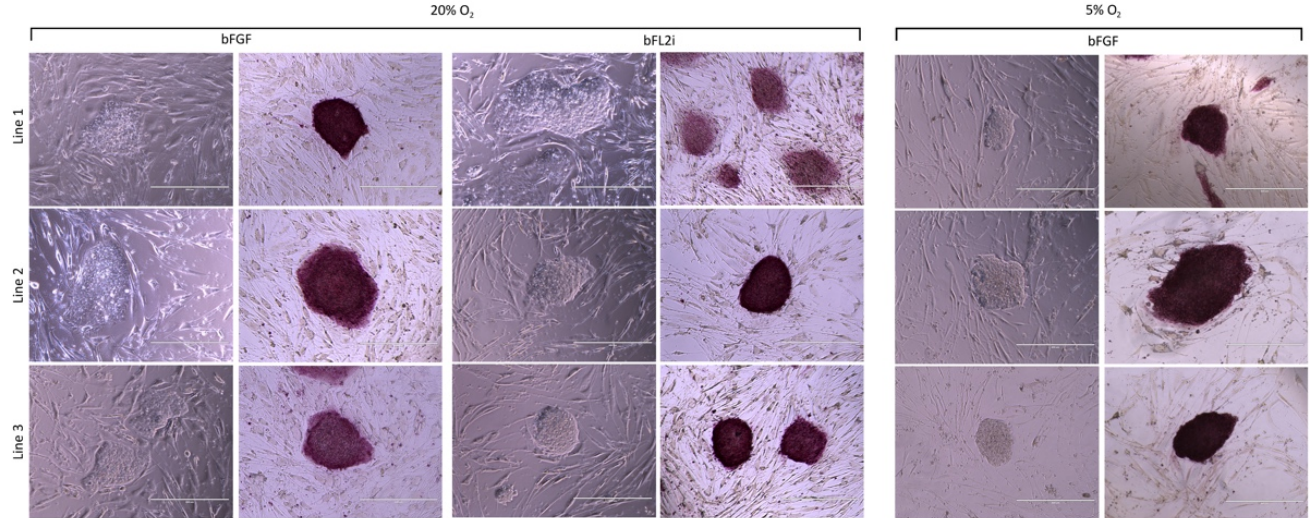
Figure 1. Bovine induced pluripotent stem cells derived in different oxygen tensions (low × high O 2 ) and pluripotent supplements (bFGF × bFL2i). All biPSCs colonies generated were small and compact colonies, with clearly defined borders, and were positive for alkaline phosphatase. Magnification 10×, Scale bars: 400 μ m.